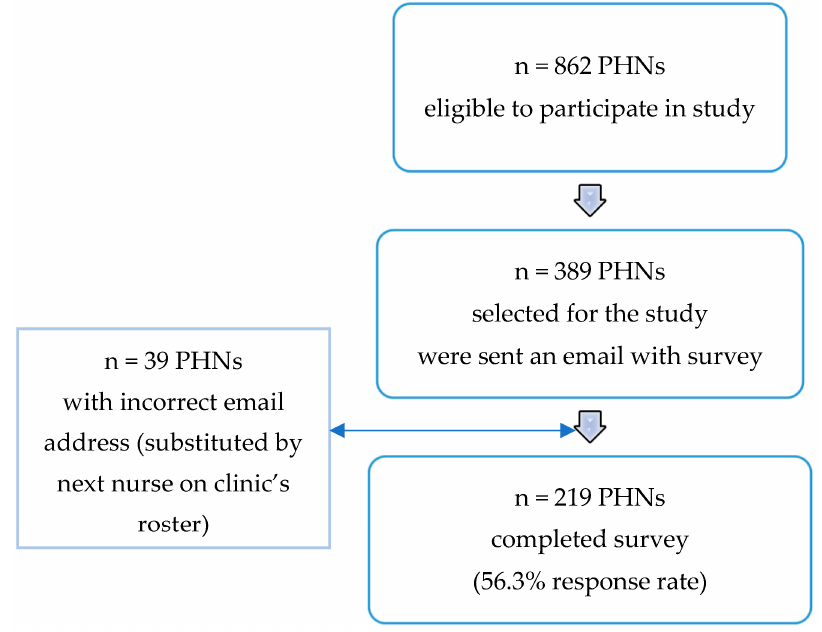
Figure 1. Research procedure flowchart.